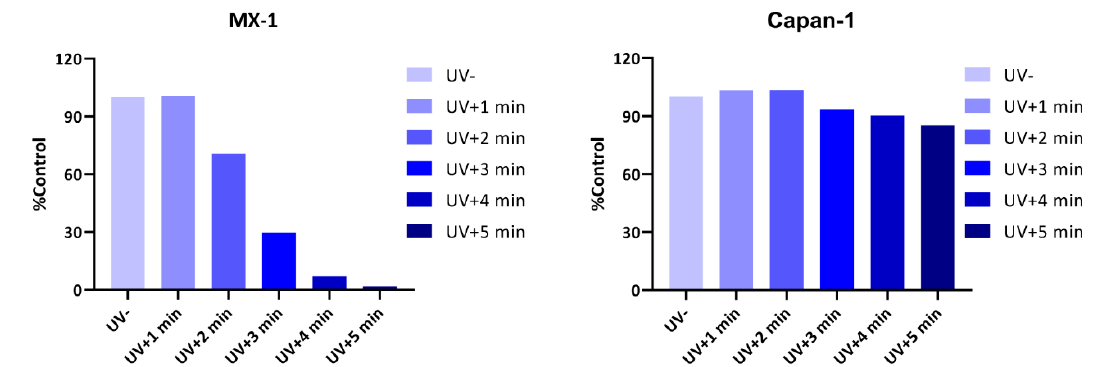
Figure 6. Cellular ultraviolet light tolerance test. Cells were irradiated at 365 nm (4.1 mW/cm 2 ) for indicated periods of time, and cell growth was determined after 10 days. The MX-1 cell line was relatively sensitive to UV irradiation. Radiation over 1 min affected cell proliferation. In contrast, the Capan-1 cell line tolerated UV irradiation for a relatively long time.